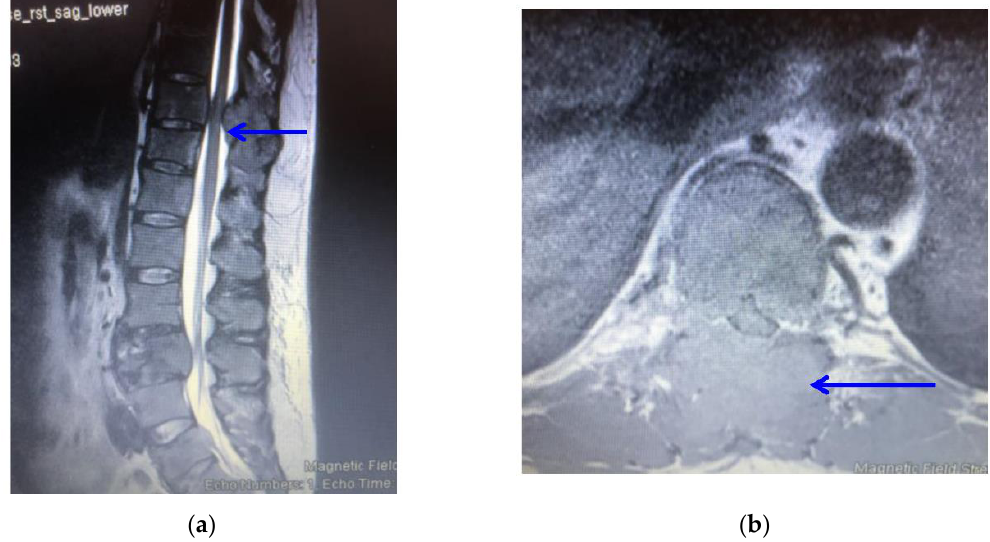
Figure 2. ( a ): T2-weighted sagittal sequence MRI scan showing an epidural soft tissue tumour compressing the spinal cord (blue arrow); ( b ): T2-weighted axial sequence MRI scan at T10 showing marked compression of the spinal cord from a soft tissue tumour (blue arrow) Plasma electrophoresis was performed to check for multiple myeloma. This revealed that IgA and IgM levels were normal. However an abnormal band was detected on plasma electrophoresis.